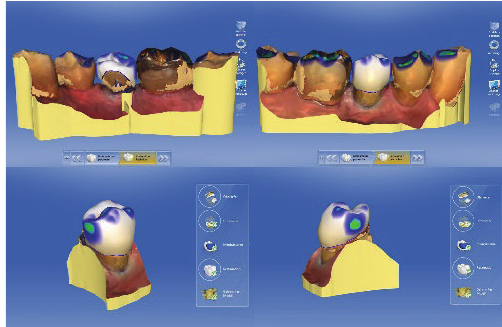
Figure 5: Adjustment of the occlusal and proximal